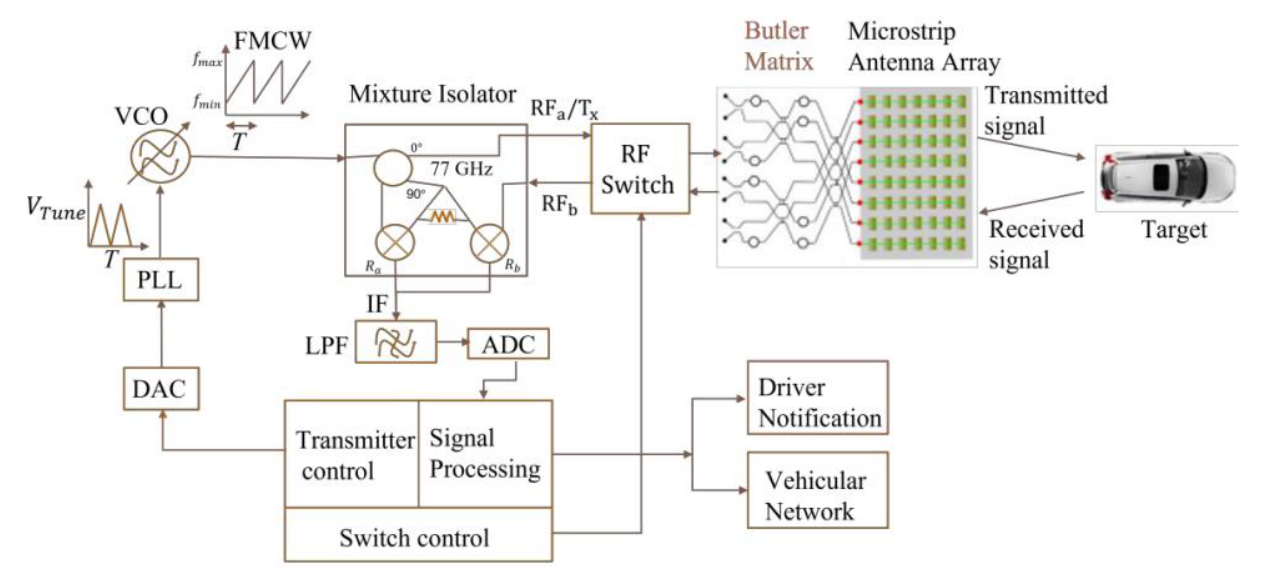
Figure 2. Block diagram of a 77 GHz automotive radar with an 8 × 8 Butler matrix.